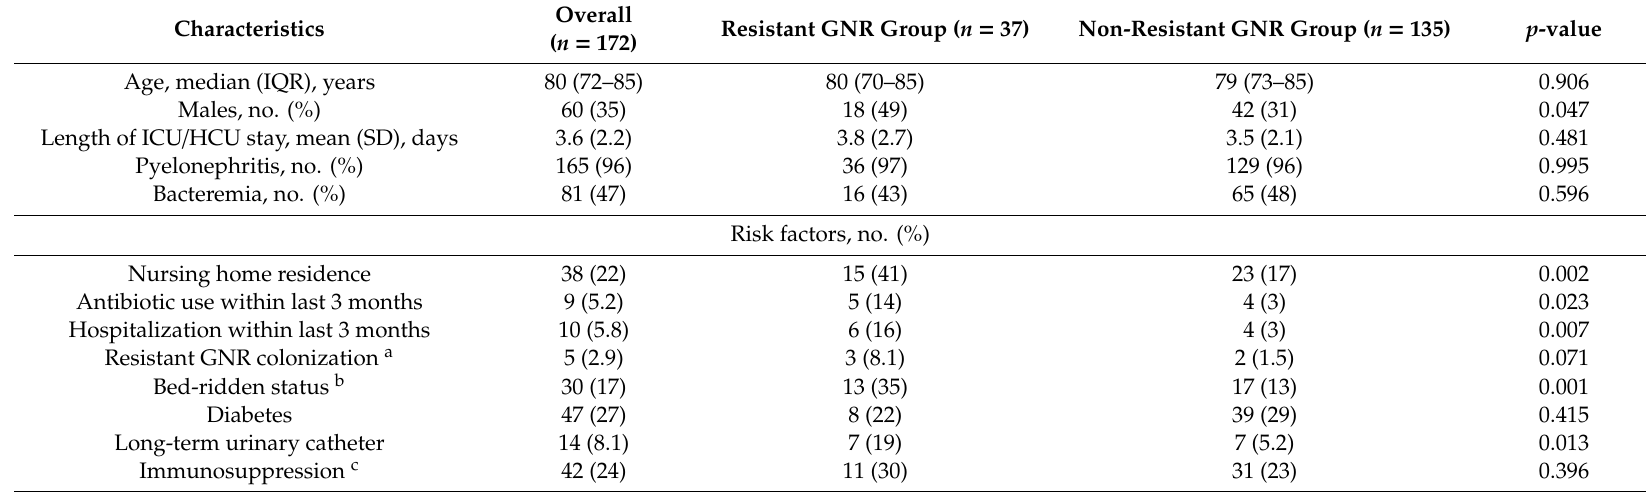
Table 1. Patient